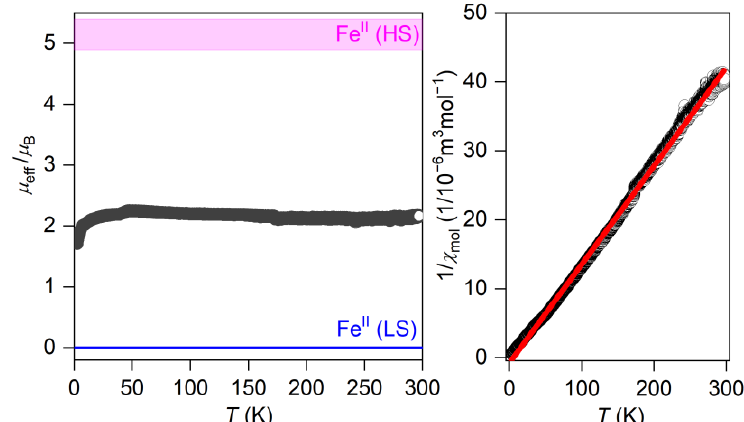
Figure 5. The temperature dependence of the effective magnetic moment (calculated from the mag- netization measured at B = 0.2 T) of 1 (left). Blue and magenta lines show typical values for LS and HS Fe II species. The linear regression to the reciprocal molar susceptibility according to Equation (1) (right).